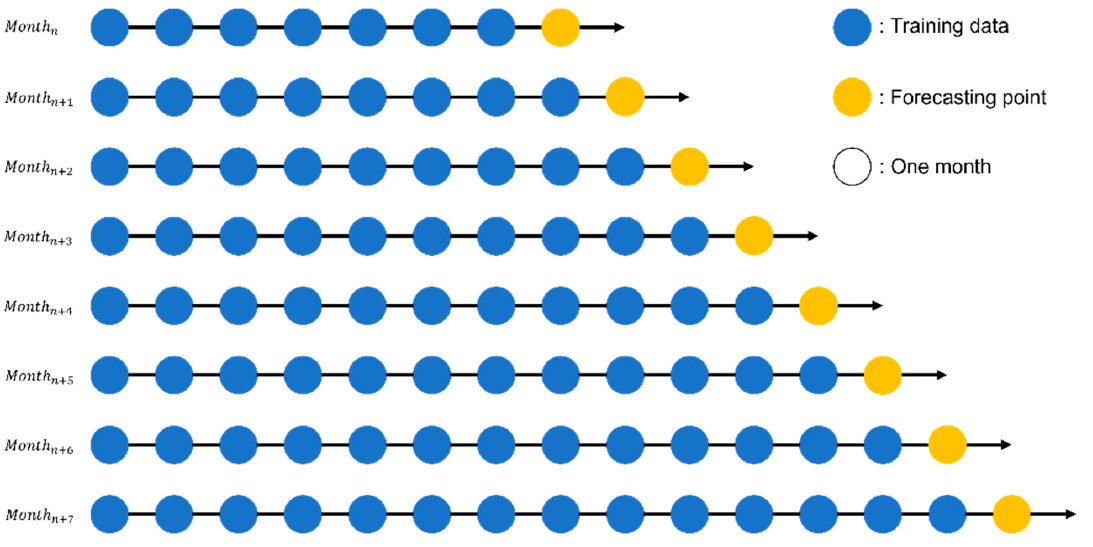
Figure 2. Example of monthly time series cross-validation.